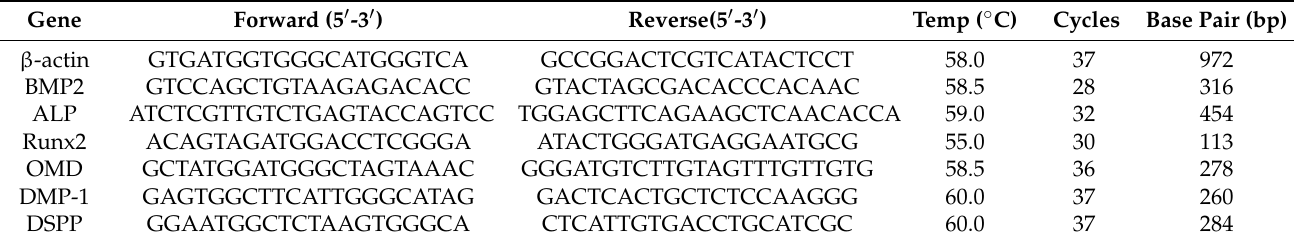
Table 1. PCR primer sequences. BMP2 ; bone morphogenetic protein 2, ALP ; alkaline phosphatase, Runx2 ; runt-related tran- scription factor 2, OMD ; osteomodulin, DMP-1 ; dentin matrix acidic phosphoprotein 1, DSPP ; dentin